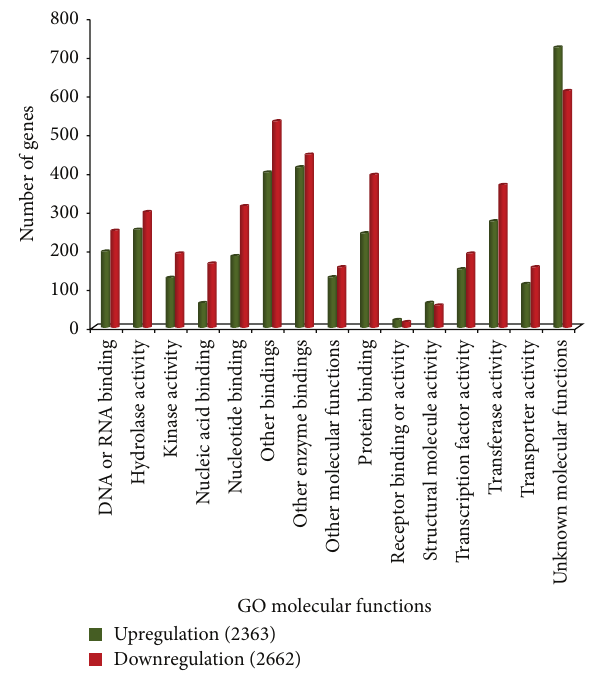
Figure 3: Gene ontology characterization by loci for molecular